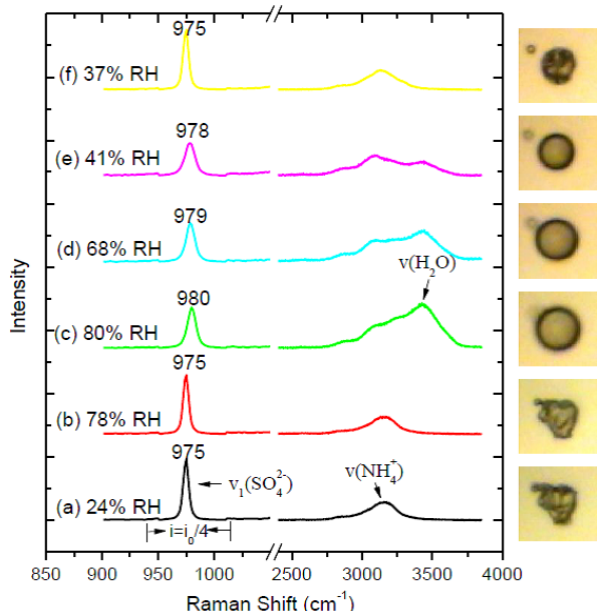
Figure 14. Raman spectra and microscopic images of an ( NH 4 ) 2 SO 4 particle during humidification (a–c) and dehumidifica- tion (c–f) . Reprint with permission by Liu (2008). Copyright 2008 Peking